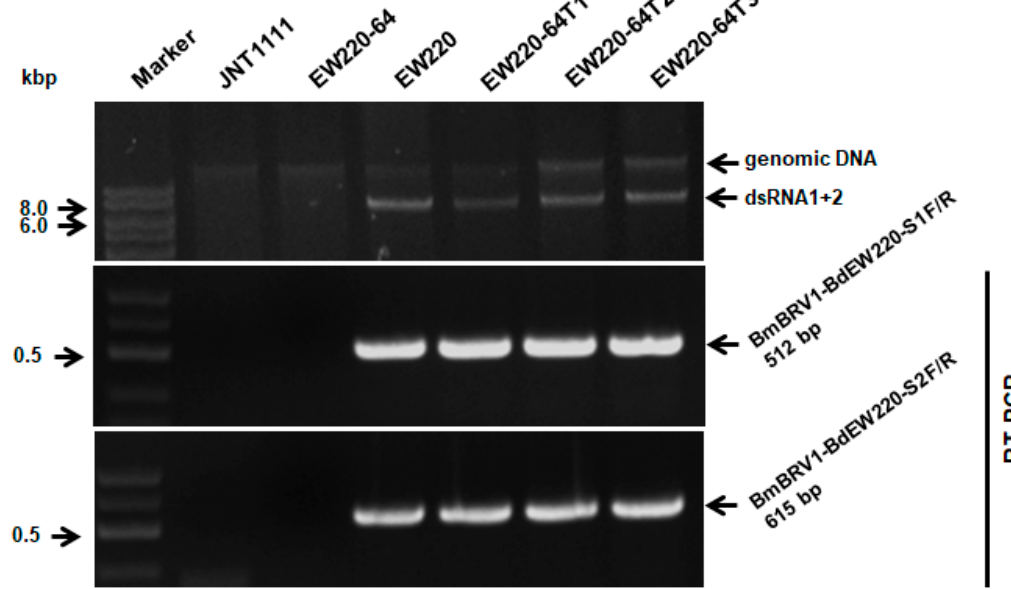
Figure 6. Detection of BmBRV1-BdEW220 in different strains of B. dothidea by dsRNAs profiling and RT-PCR with specific primers. Strains EW220-64-T1, EW220-64-T2, and EW220-64-T3 were derived